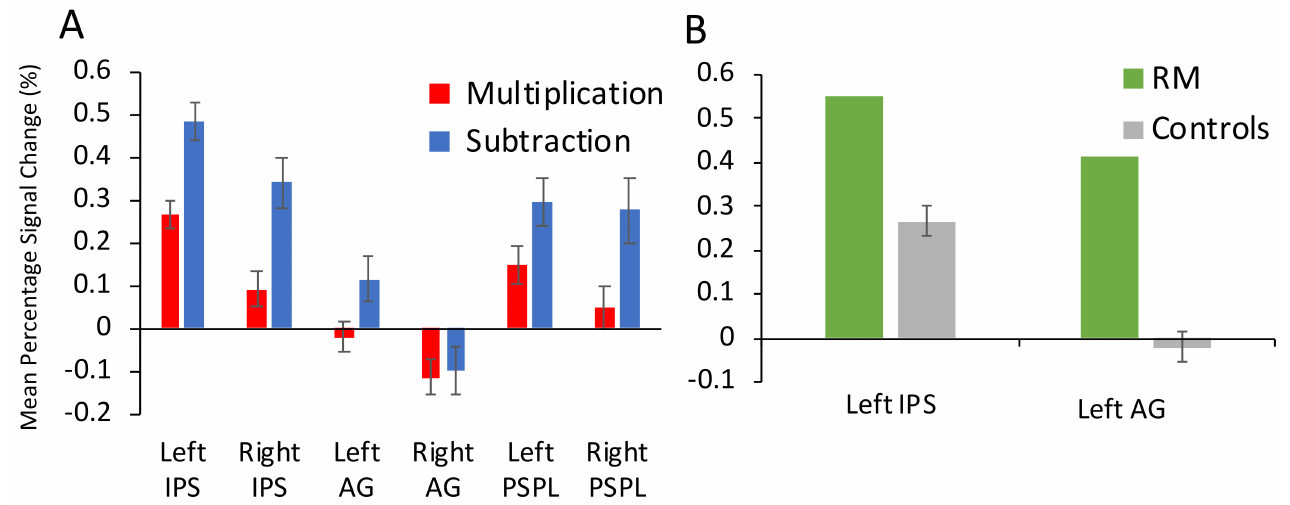
Figure 3. ( A ) Mean percentage signal change in six ROIs (left and right IPS, left and right AG, and left and right posterior superior parietal lobule) by task (multiplication in red, subtraction in blue) for the control group, ( B ) Mean percentage signal change during multiplication in the left IPS and the left AG for RM (in green) and the control group (in